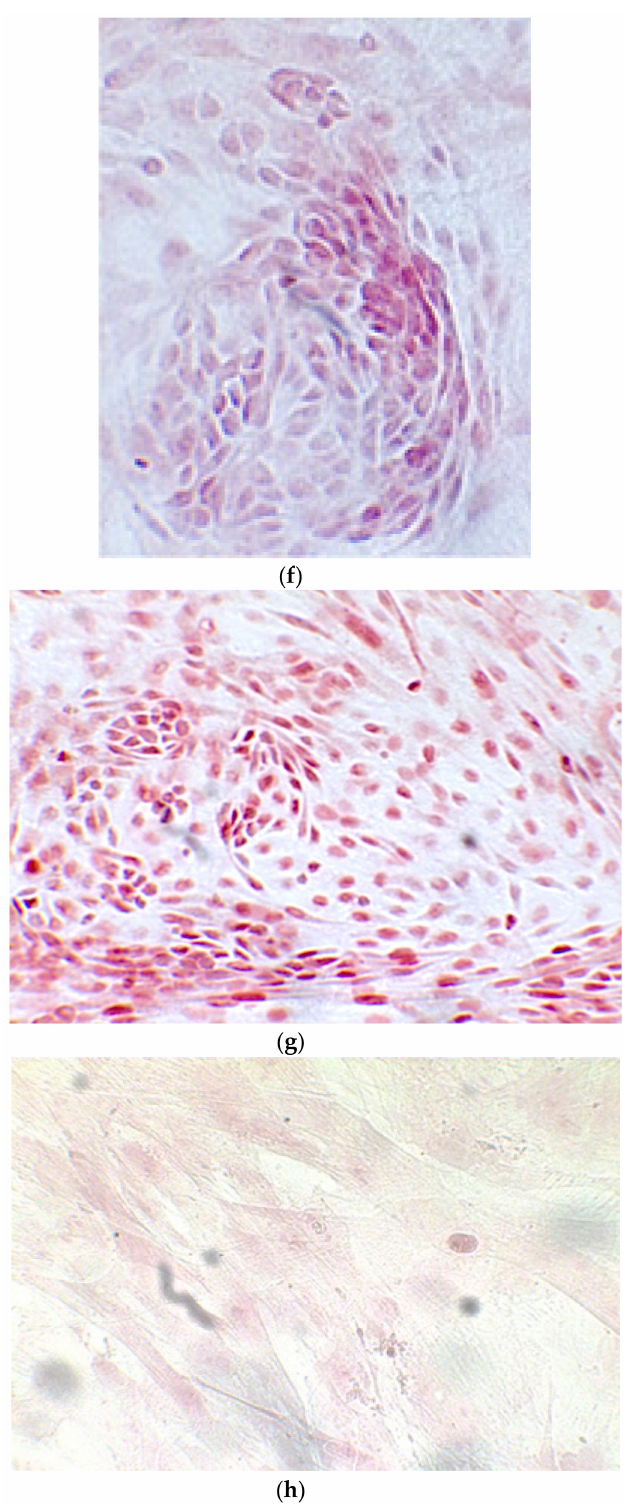
Figure 6. Since the first images processed under the microscope after staining with alizarin, we see that those after 14 days are positive to the test of alizarin, so the partially di ff erentiated cells include calcium. We have one image for control CTR2#6 P19 ( a ), five images for CTR8#14 P12 – RA ( b–f ) control, being the best clone, and one image for control CTR8#14 P12 + retinoic acid ( g